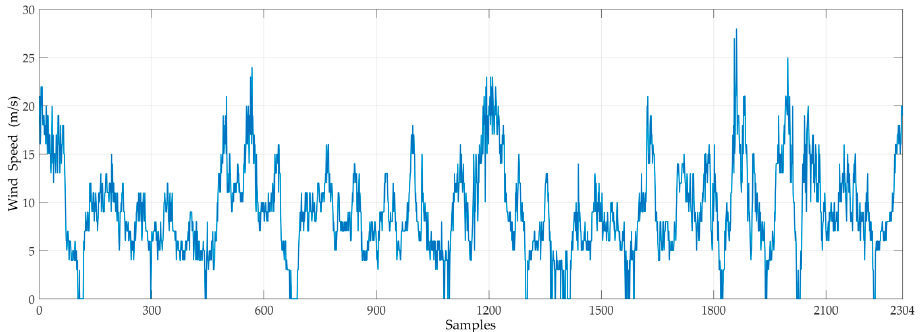
Figure 5. Original wind speed series from 28 October 2011 to 28 November 2011.